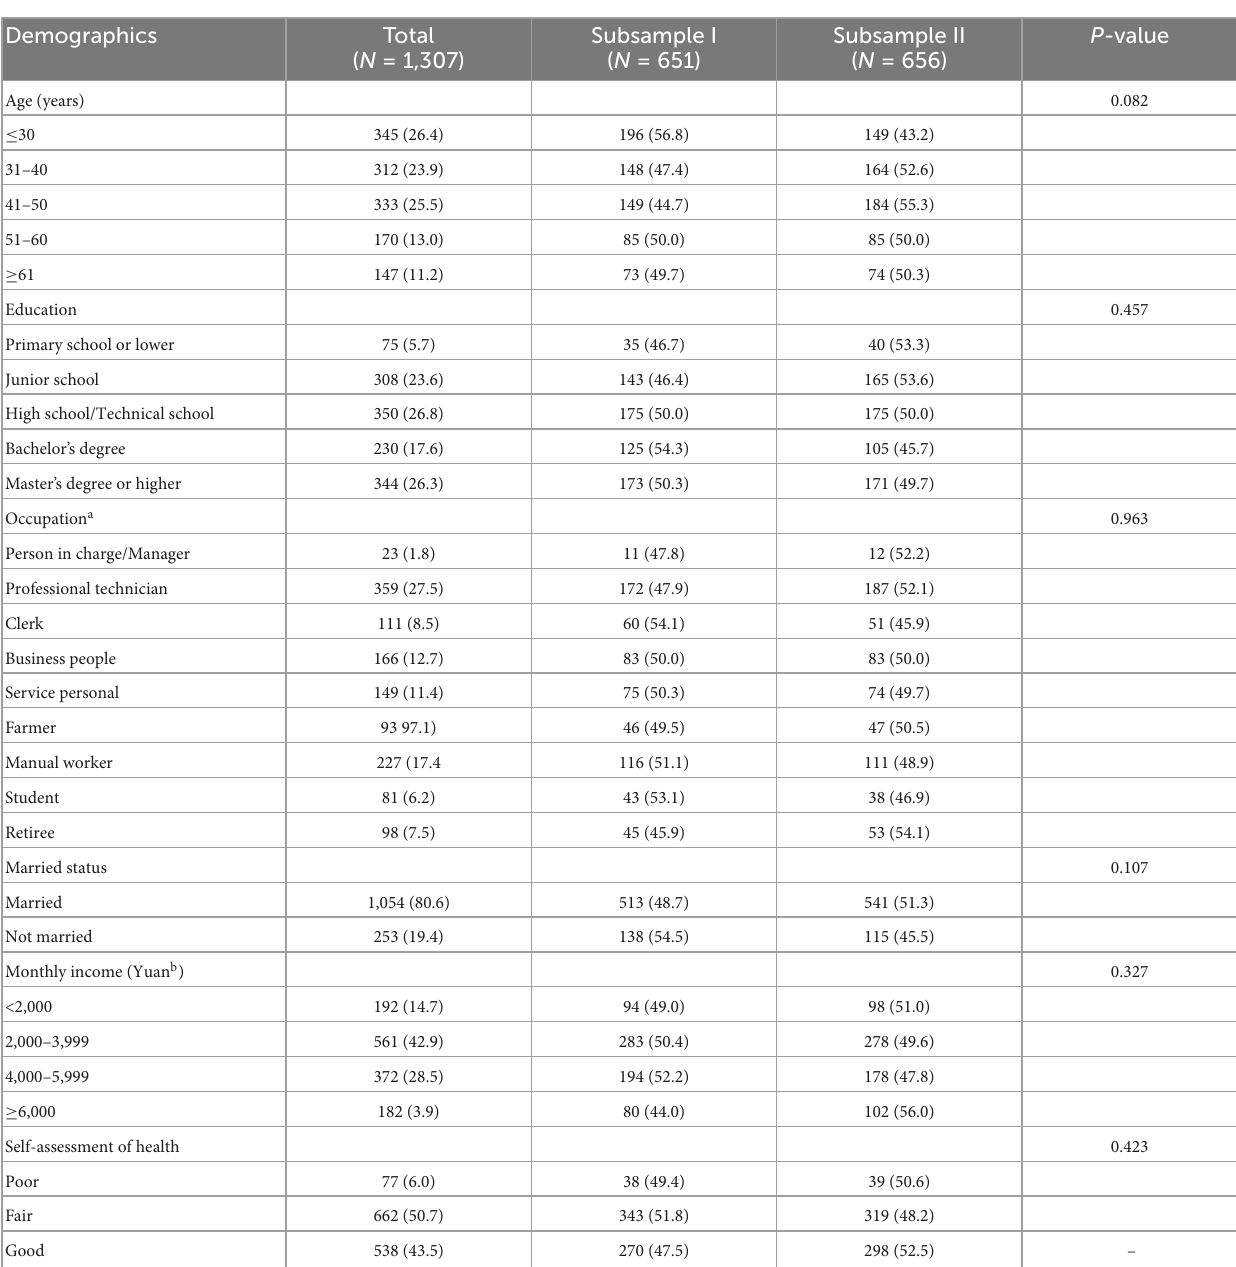
TABLE 2 Demographic characteristics of